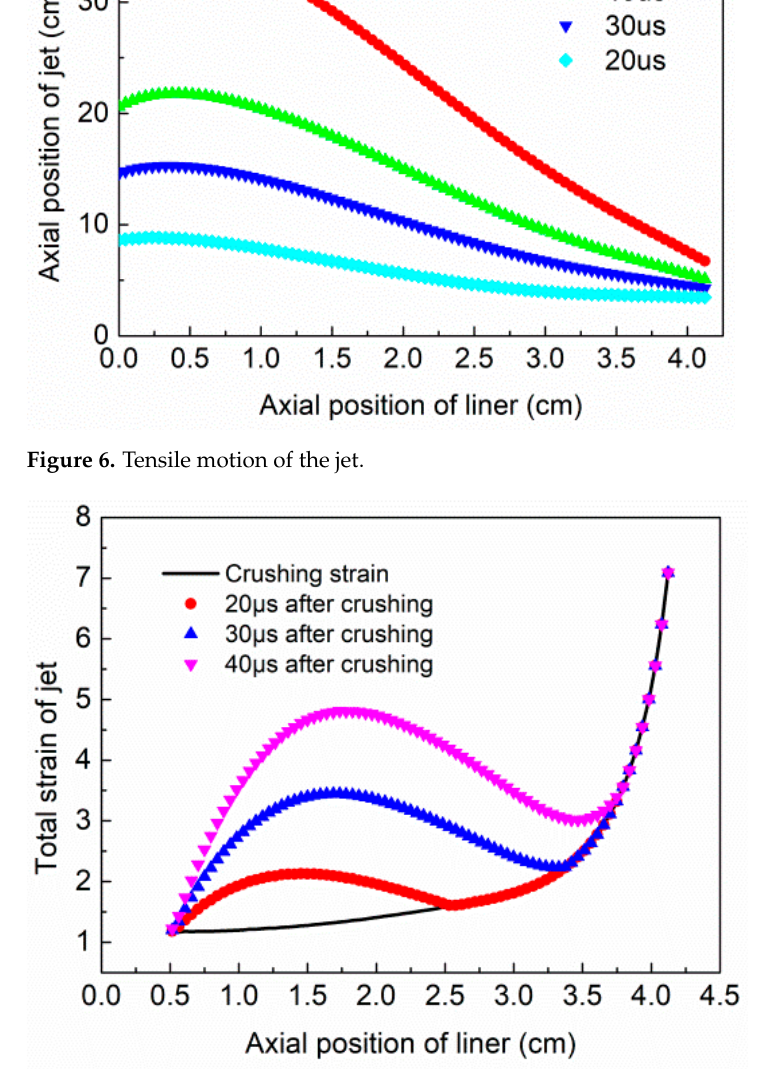
( b ) Figure 8. Strain distribution of the OFHC-Cu and Mo jets (at 40 µs). ( a ) Theoretical predictions; ( b ) Numerical simulations. 4.3. Strain-Rate Distribution of the Jets Figure 9a,b show the theoretically calculated distribution pa tt erns of the deformation strain rates of the OFHC-Cu and Mo jets during collapse and stretching (at 40 µs), respectively. Overall, the deformation strain rates of the materials during the collapse process ranged primarily from 7 × 10 4 and 1.6 × 10 5 s –1 . Compared with the collapse